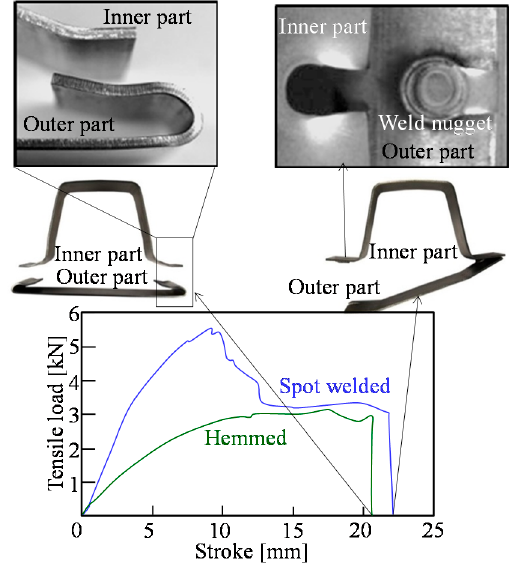
Figure 15. Load–stroke curve in tensile test for joined 1180 MPa steel sheets.